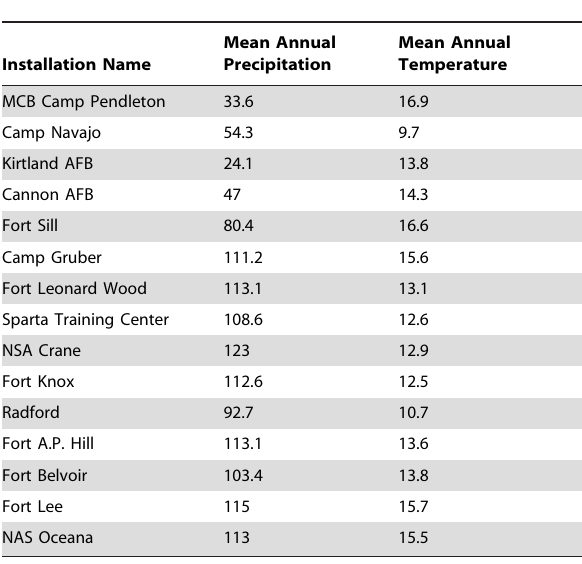
Table 4. Mean annual precipitation (cm) and temperature ( u C) at each of the fifteen DoD installations